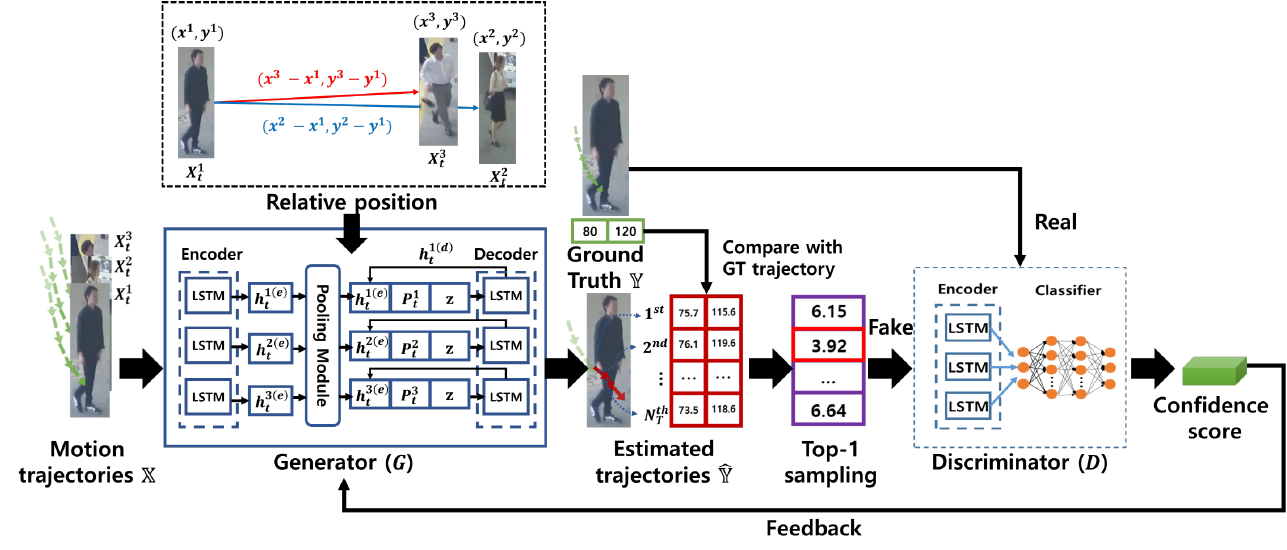
Figure 5. The architecture of our global relation motion